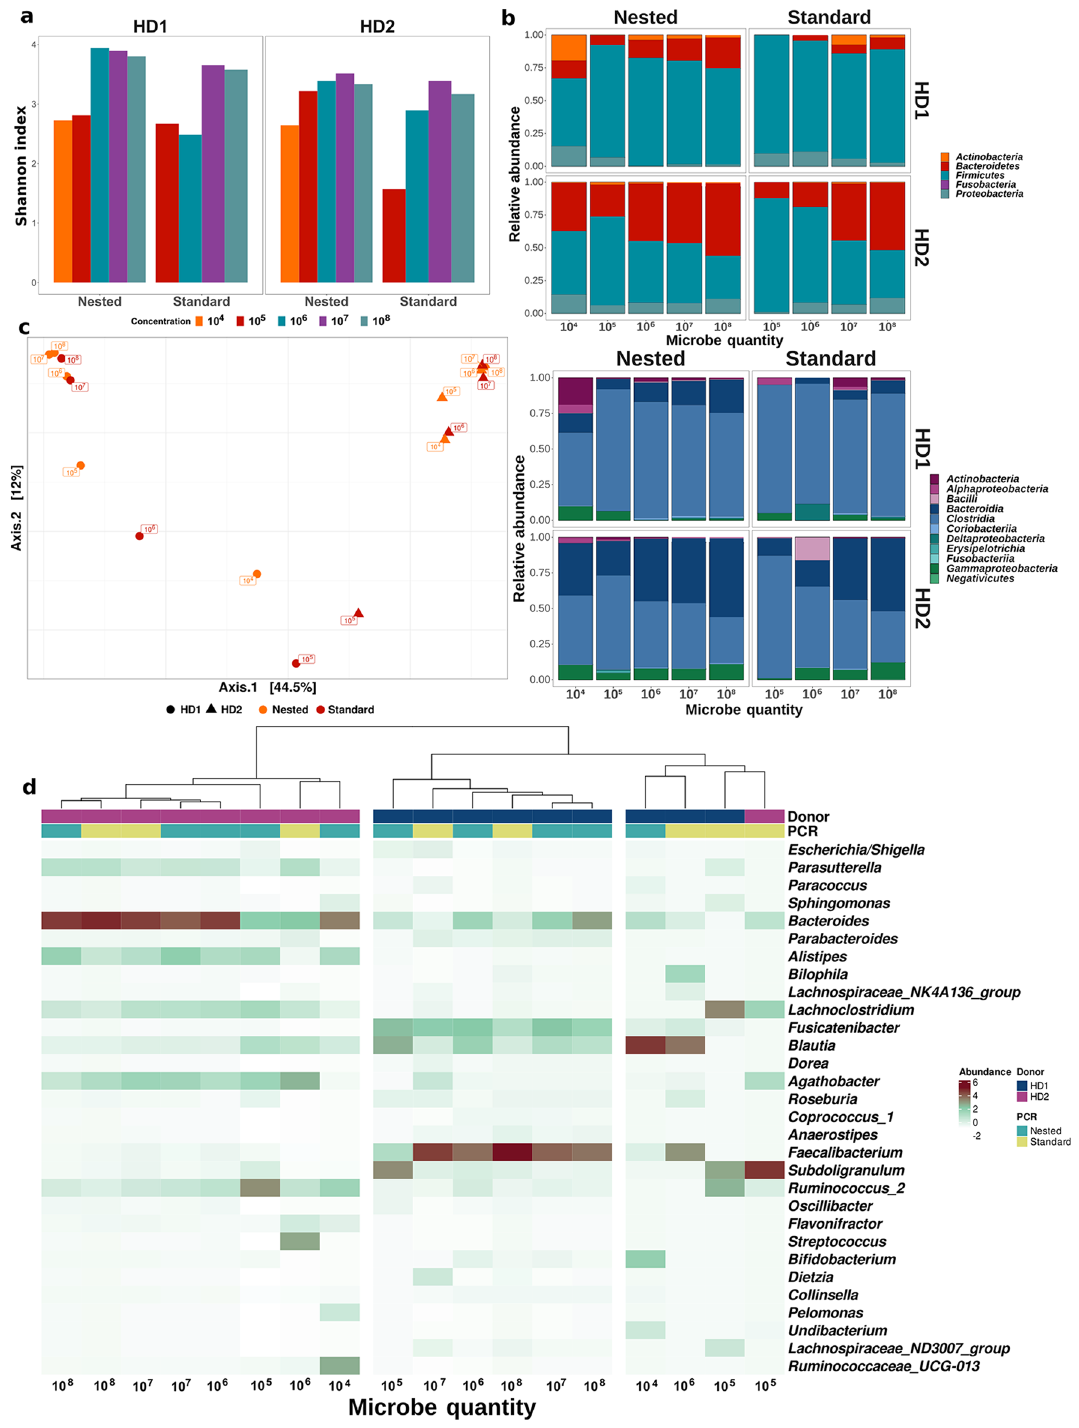
Figure 2. Effect of low biomass and PCR protocols on the representation of microbiota composition. ( a ) Alpha- diversity of low biomass samples. ( b ) Microbial composition at Phylum (upper panel) and Class (lower panel) phylogenetic level. ( c ) Principal coordinate analysis (PCoA) of samples using Bray–Curtis distance. Samples are labeled based on their cell content, shape represents donors and colors represent PCR protocols for each sample. ( d ) Heatmap of the top 30 most abundant genera, clustered using Bray–Curtis distance. Donor origin is represented by the first color layer and PCR protocols are represented by the second color layer. Of note, all samples were exposed to the same DNA extraction protocol (bead-beating for 3 × 30 s and purified on silica filters). Figures were generated using R 39